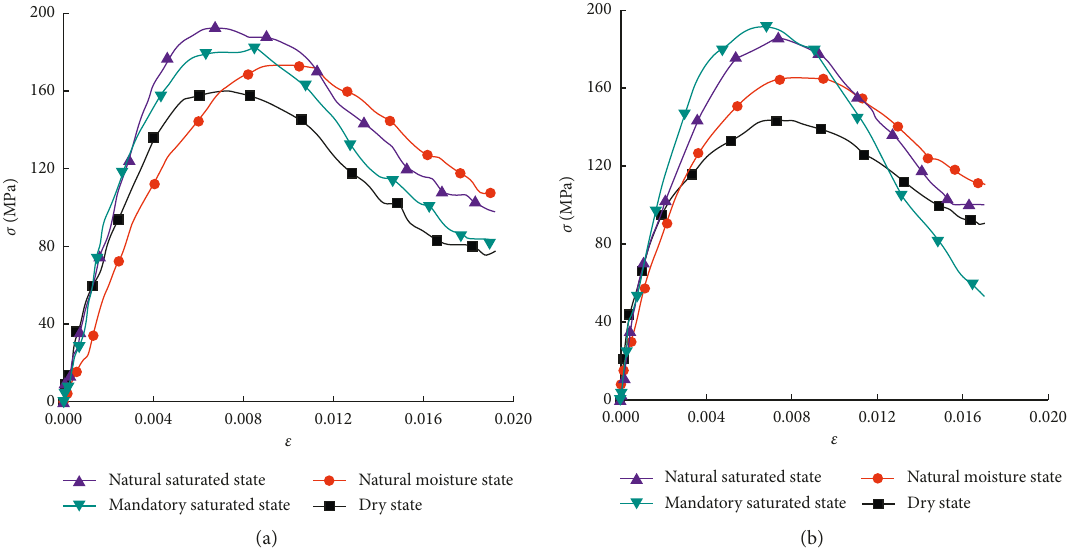
Figure 6: Dynamic stress-strain curves for sandstone specimens. (a) Yangzhuang coalmine ( _ ε � 198s − 1 ). (b) Hengyuan north auxiliary shaft ( _ ε � 200s − 1